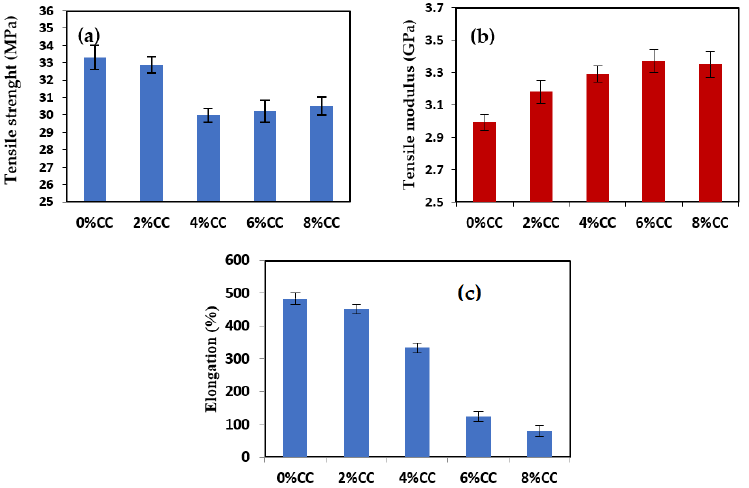
Figure 6. Effect of filler loadings on the 3D printed specimen: ( a ) Tensile strength; ( b ) Tensile modulus; and ( c ) Percentage